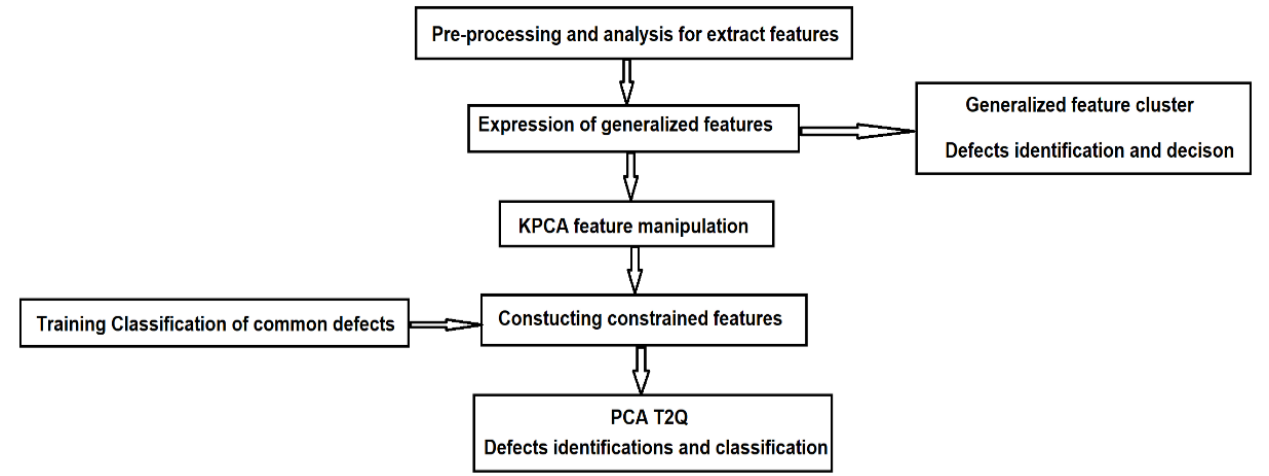
Figure 25. The flow chart of the proposed algorithm.